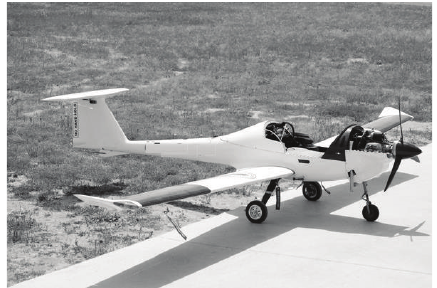
Figure 1: KUAV scale